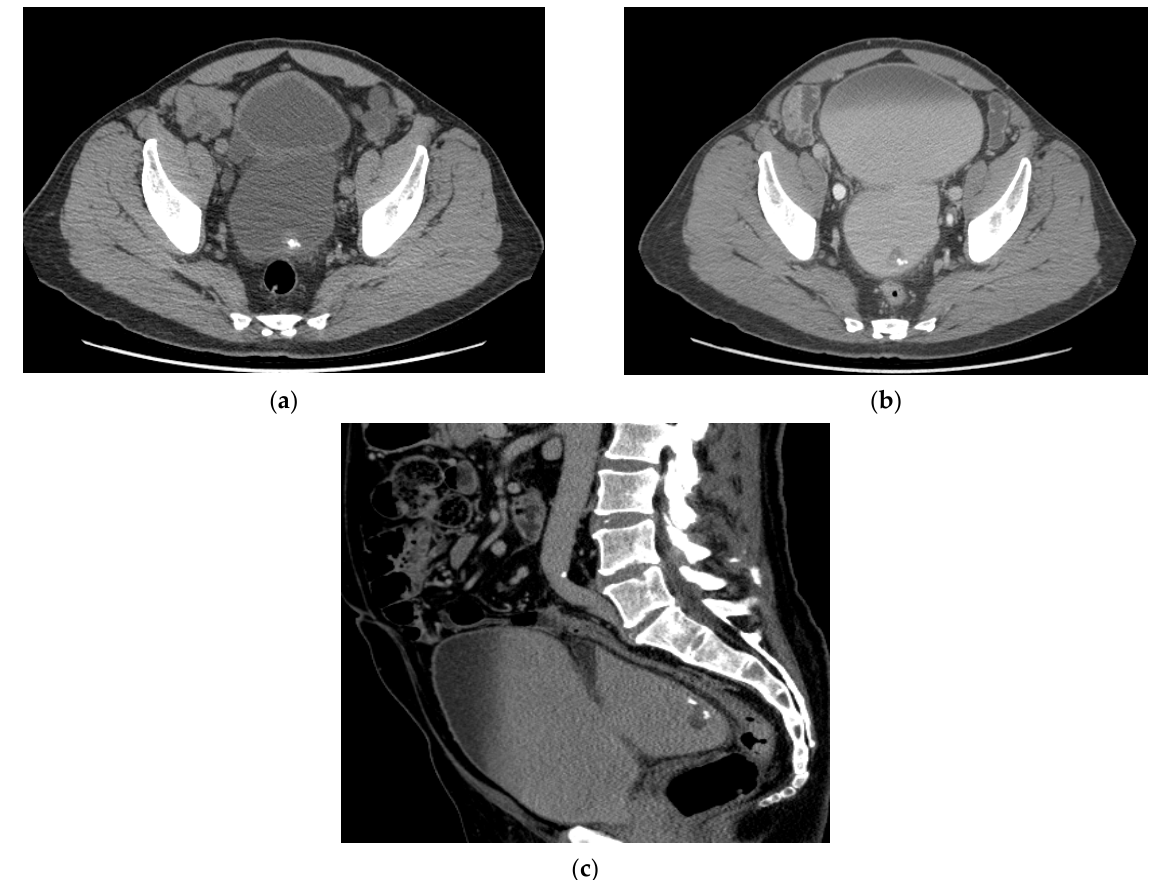
Figure 4. CT urogram with partially calcified urothelial carcinoma within a large bladder diverticulum ( a ) Axial CT image obtained without contrast shows a large bladder diverticulum containing a partially calcified lesion along the posterior aspect representing urothelial carcinoma. ( b ) Axial CT image obtained during the excretory phase and ( c ) Sagittal excretory phase image show the same mass as a filling defect surrounded by excreted urine in the bladder.